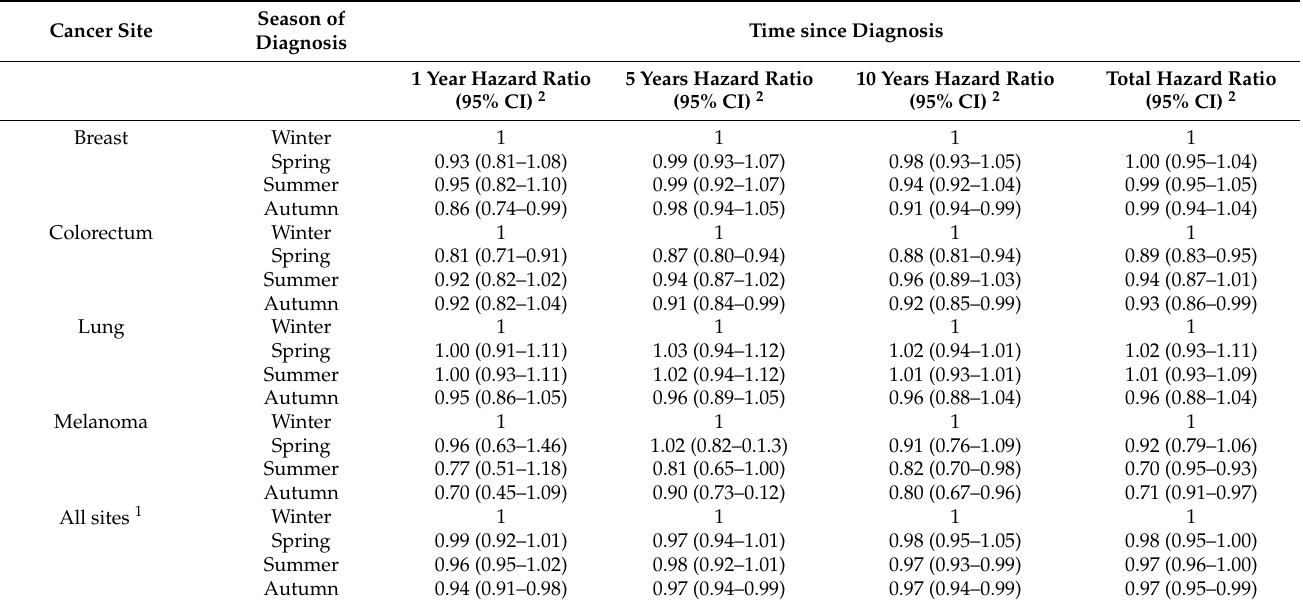
Table 2. Mortality Hazard Ratios by season of diagnosis and time since diagnosis in women.